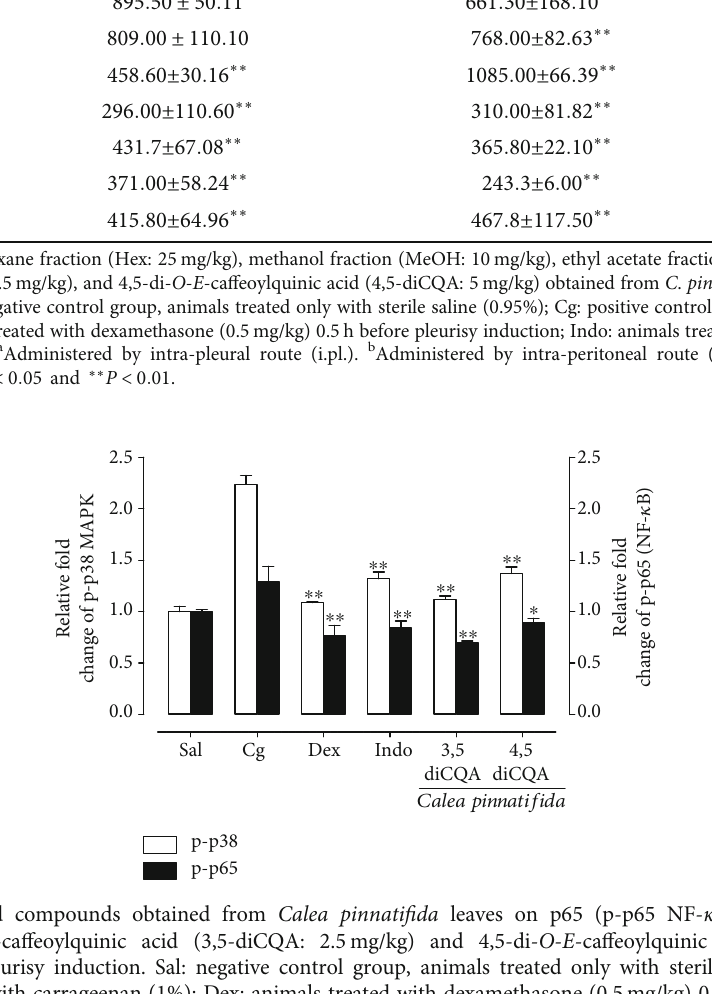
Table 3: E ff ects of CE, fractions, and isolated compounds of C . pinnati fi da upon tumor necrosis factor-alpha (TNF- α ), interleukin-1 β (IL-1 β ), and interleukin-17A (IL-17A) in a murine model of carrageenan-induced pleurisy. Groups (mg/kg) TNF- α (pg/mL) IL-1 β (pg/mL)